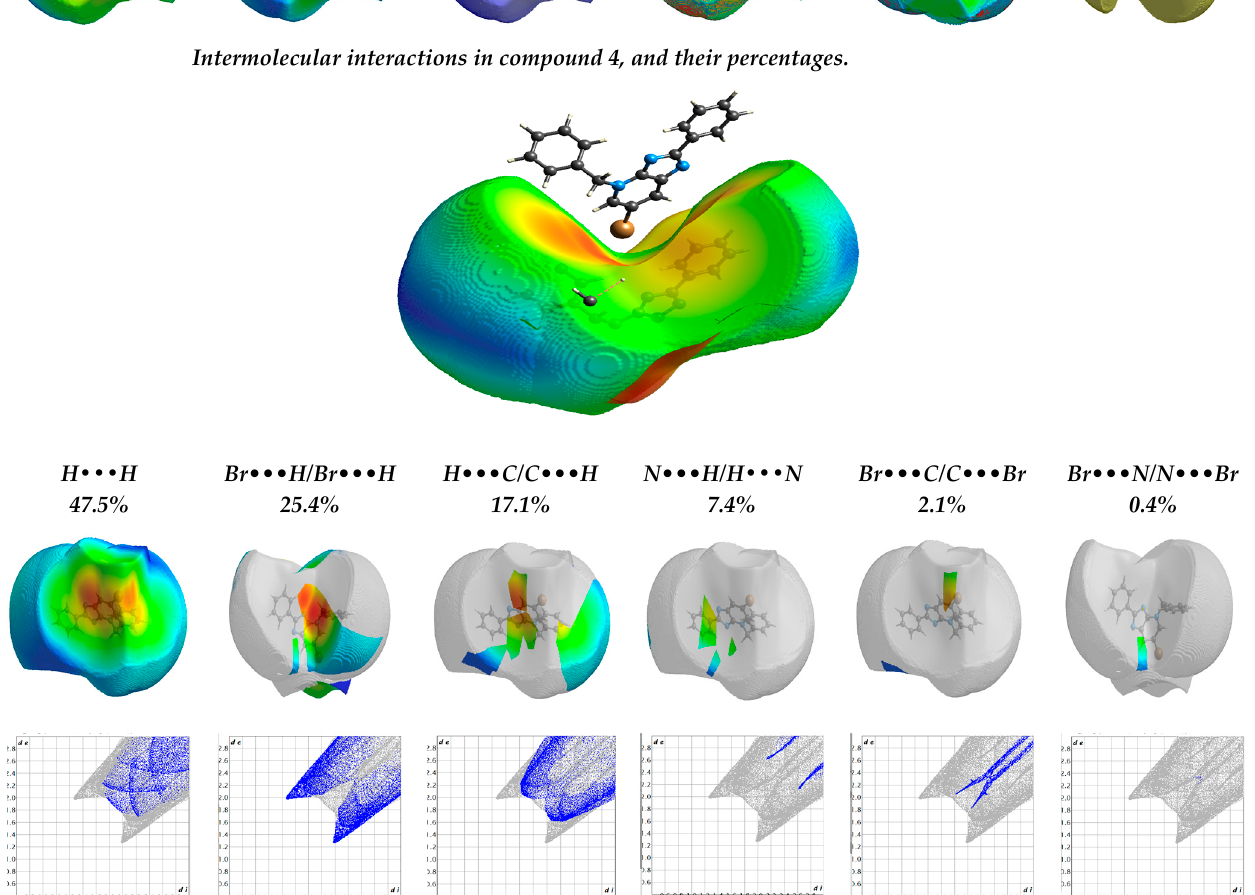
Figure 3. HF and 2D interaction diagrams and their impact in compound 3 .